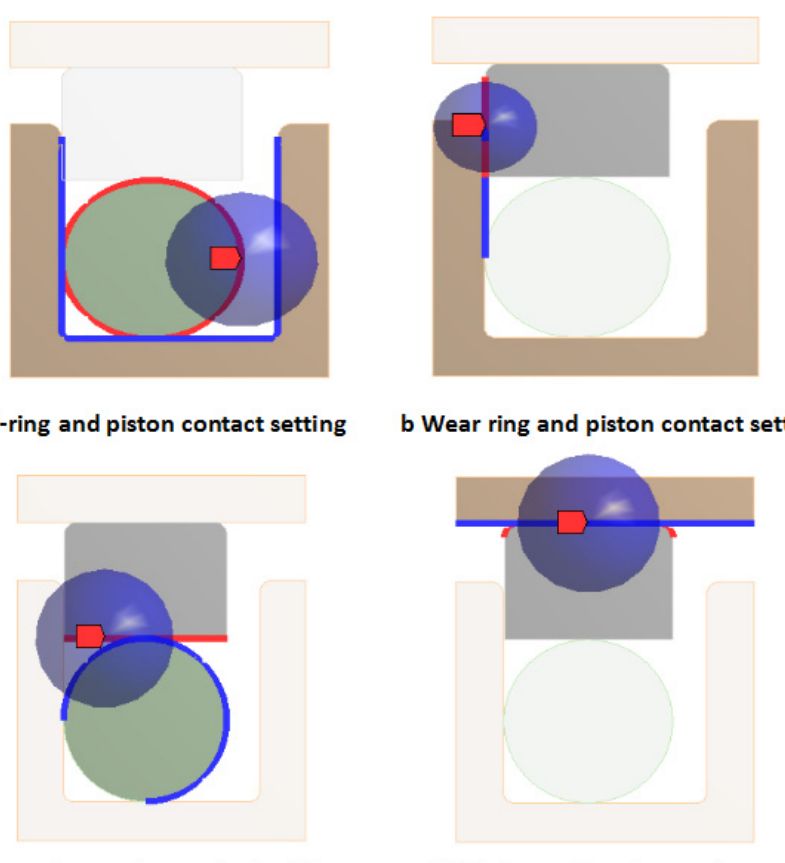
Figure 2. Combination seal ring contact analysis settings.